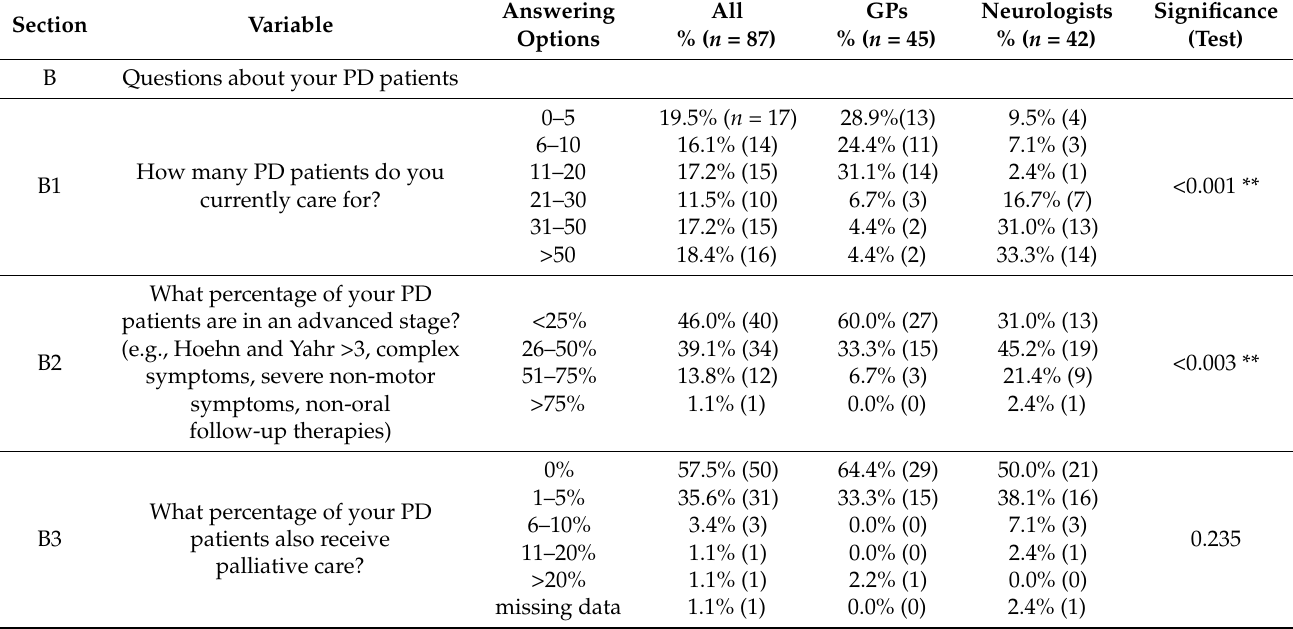
Table 2. Advance care planning in outpatient